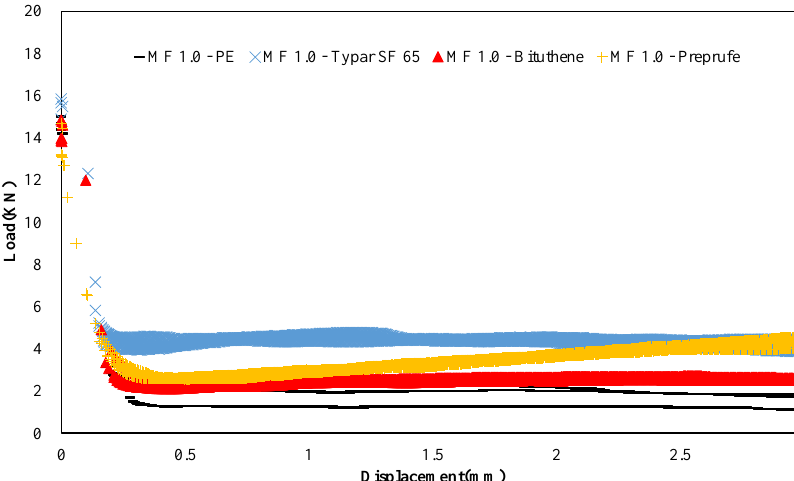
Figure 5 . Load-displacement curve during crack propagation (MF 1.0).